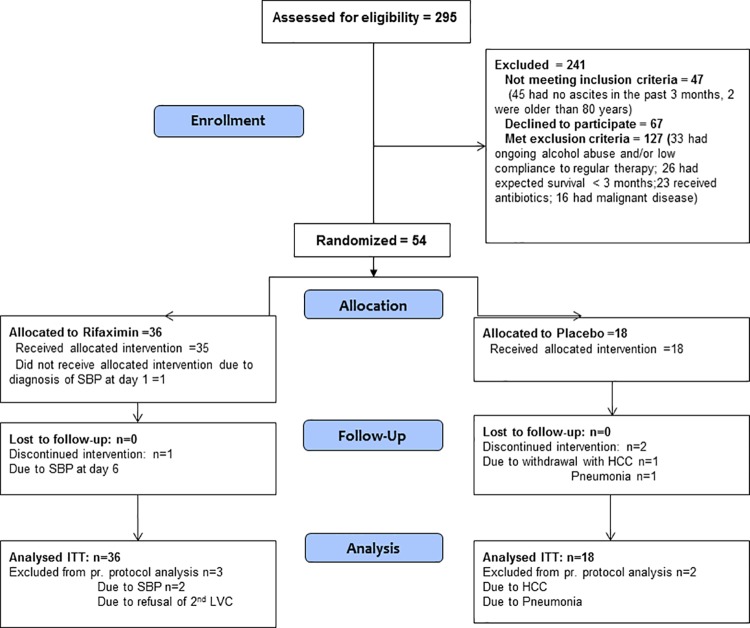
Trial flow diagram.